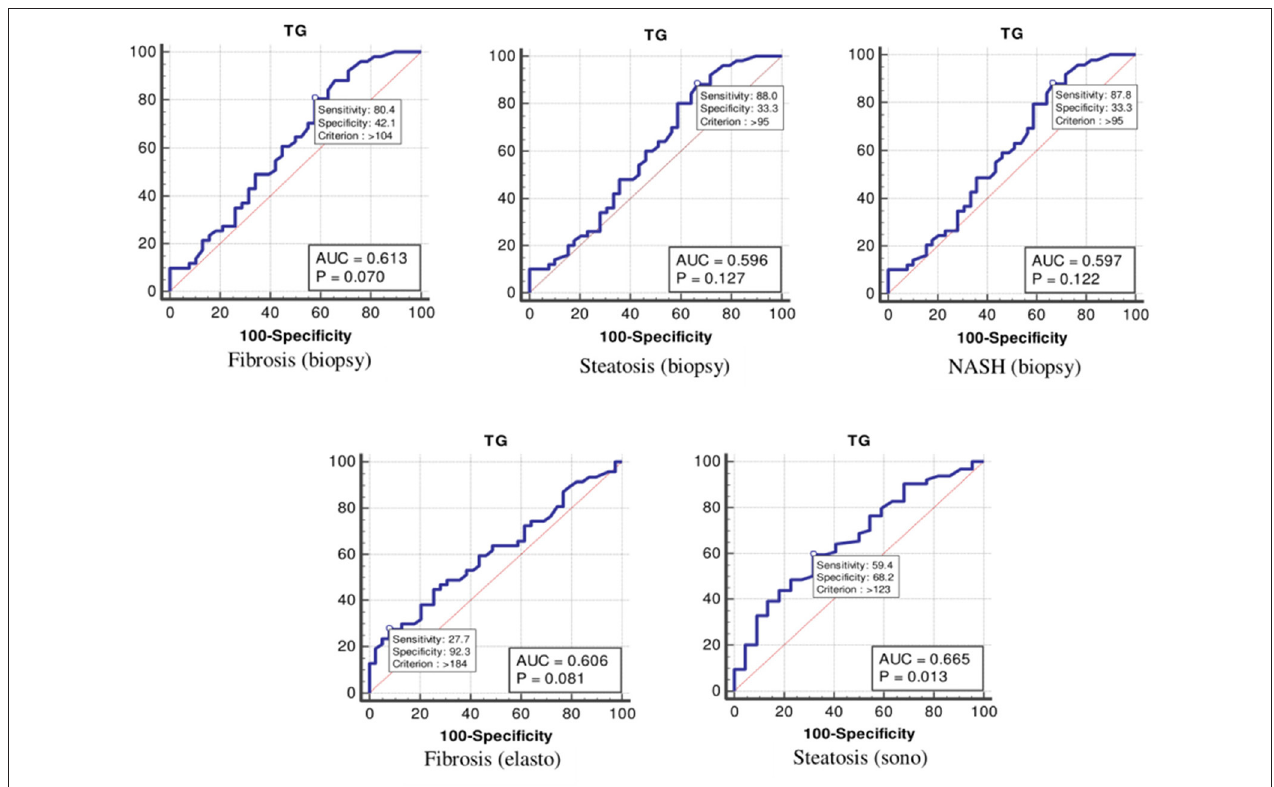
FIGURE 5 | The receiver operating characteristics curve for triglycerides in the detection of liver disease.